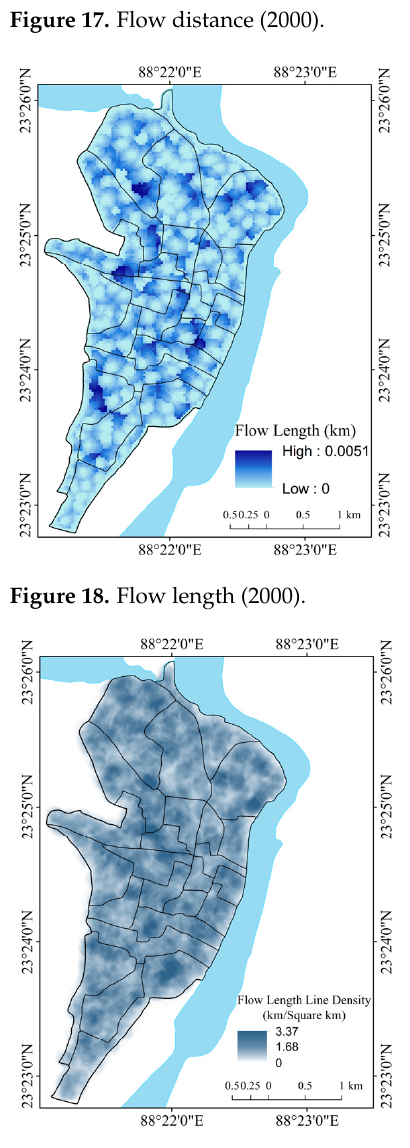
Figure 19. Flow length line density (2000).